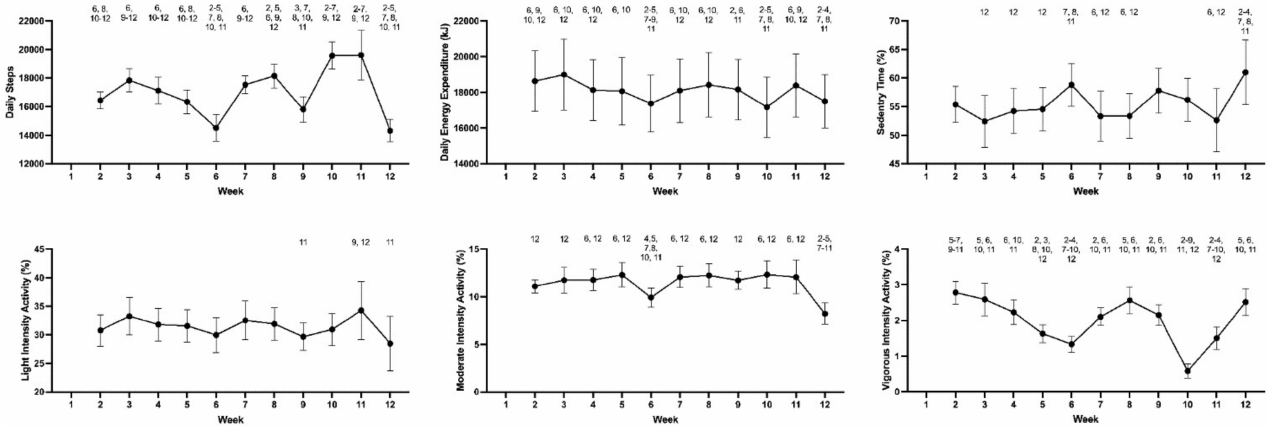
Figure 1. Physical activity measures across the 12 week BMT program (mean ± 95% confidence intervals). Note: Numbers above data points denote a significant difference to the detailed week ( p < 0.05).